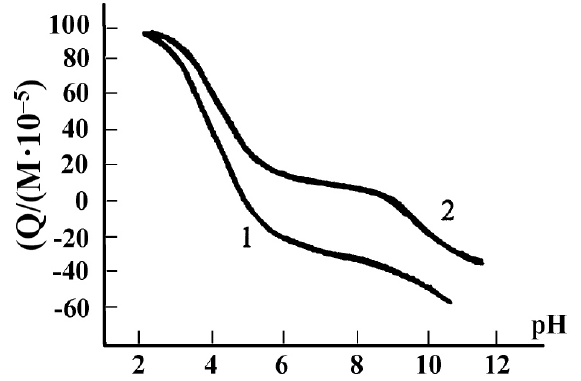
Figure 4. Dynamics of changes in the total electric charge of gelatin macromolecules in terms of a unit of molecular mass (in (Q/(M · 10 –5 ) values) depending on the pH of the medium: 1 —for alkaline gelatin, 2 —for acid gelatin. (This figure was made by the author of the given article according to the data presented in [78]).